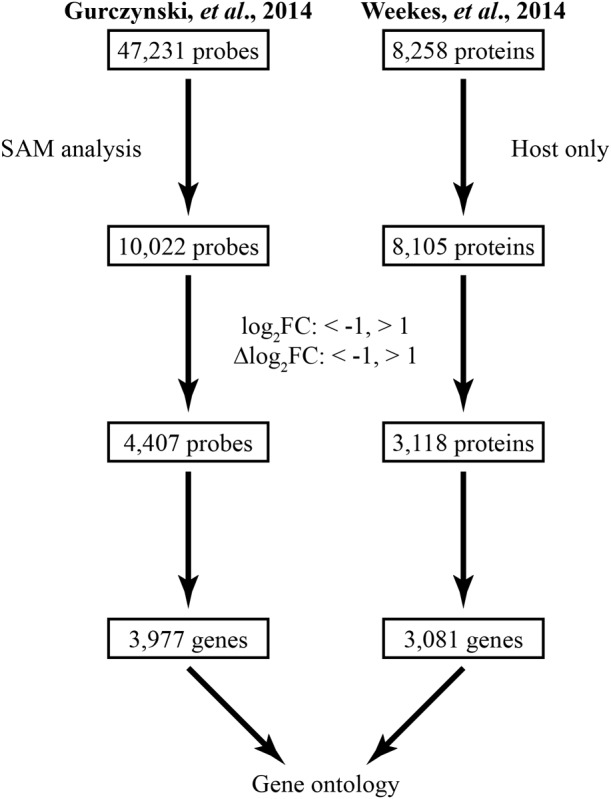
Gene curation scheme for the transcriptional and proteomic datasets. The transcriptional dataset (left) was curated using SAM analysis (false discovery rate = 0.01) before being subjected to biological significance thresholds based on the log2FC and Δlog2FC. The proteomic dataset (right) was similarly filtered. First, host cellular proteins were chosen, then, only proteins that passed the log2FC-, Δlog2FC-based significance thresholds were selected. The resulting lists of 3,977 and 3,081 unique genes curated from the transcriptional and proteomic datasets, respectively, were used for gene ontological analysis.